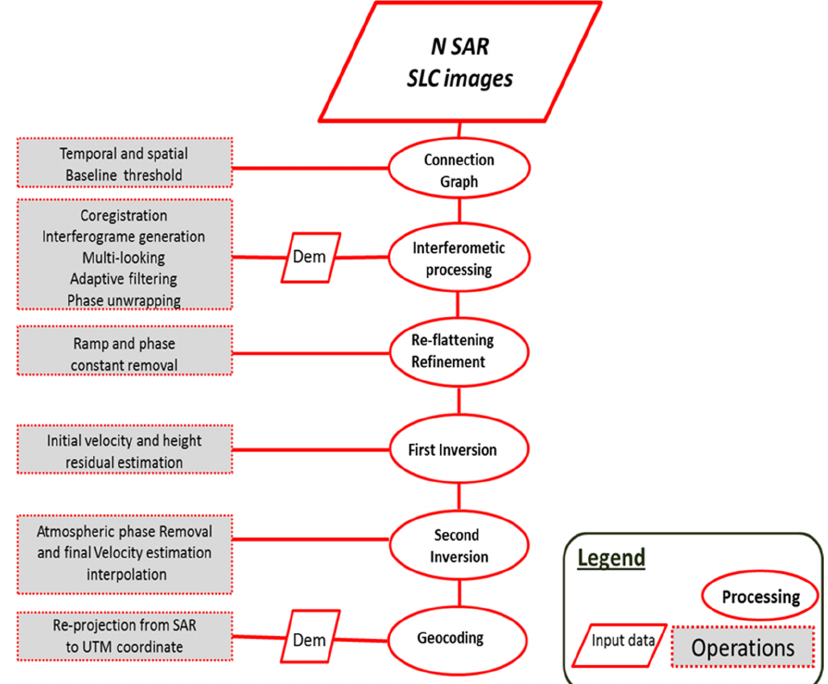
Remote Sens. 2021 , 13 , x FOR PEER REVIEW